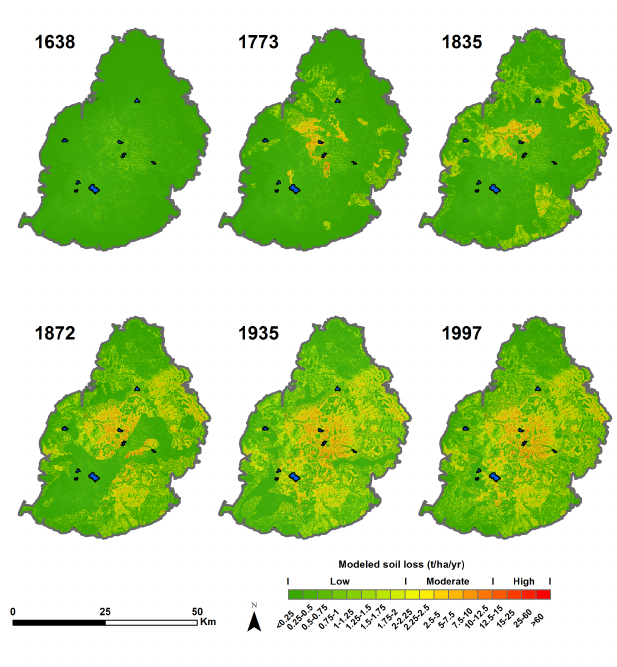
Fig. 4. Modeled soil loss for six timeslices since colonization in 1638. For visualization purposes, the modeled soil loss has been classified into three classes: low (0–2 t/ha/yr), moderate (2–12.5 t/ha/yr), high (>12.5 t/ha/yr).